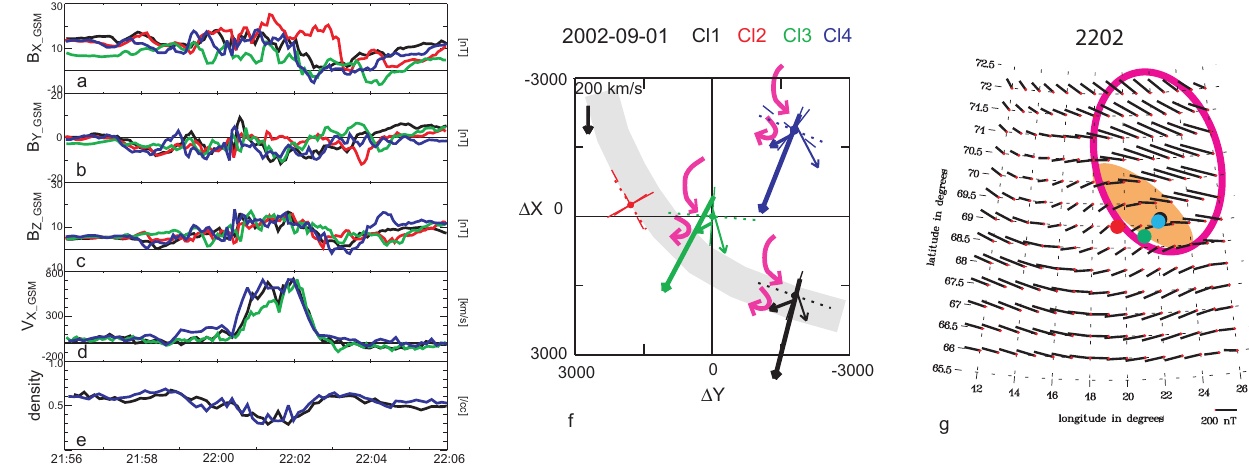
Fig. 20. Cluster observation of (a) X, (b) Y, and (c) Z components of the magnetic field (in GSM coordinates), (d) X component of the ion flow, (e) proton density, between 21:56 and 22:06 UT. For the ion plots, proton data from the CODIF instrument are used for Cluster 1 and 4, while ion data from the HIA instrument are shown for Cluster 3. (f) Location of the four Cluster spacecraft relative to the reference spacecraft (Cluster 3) in GSM X-Y plane. The dotted lines show the projection of the dipolarization front described in the text. The thick arrows are the plasma flows at the interval of maximum flow speed while the thin, short arrows correspond to the flow vector just before and after dipolarization front. The possible shape of the dipolarization front is illustrated with a gray curve. The flow shear direction is shown with pink arrows. (g) Equivalent current pattern at 22:02 UT together with the magnetic footpoints of Cluster. The most likely location of the conjugate region of the flow channel (area surrounded by pink line) and the center of the precipitation (orange) as inferred from the magnetosphere-ionosphere observation are illustrated. (Adapted from Nakamura et al.,